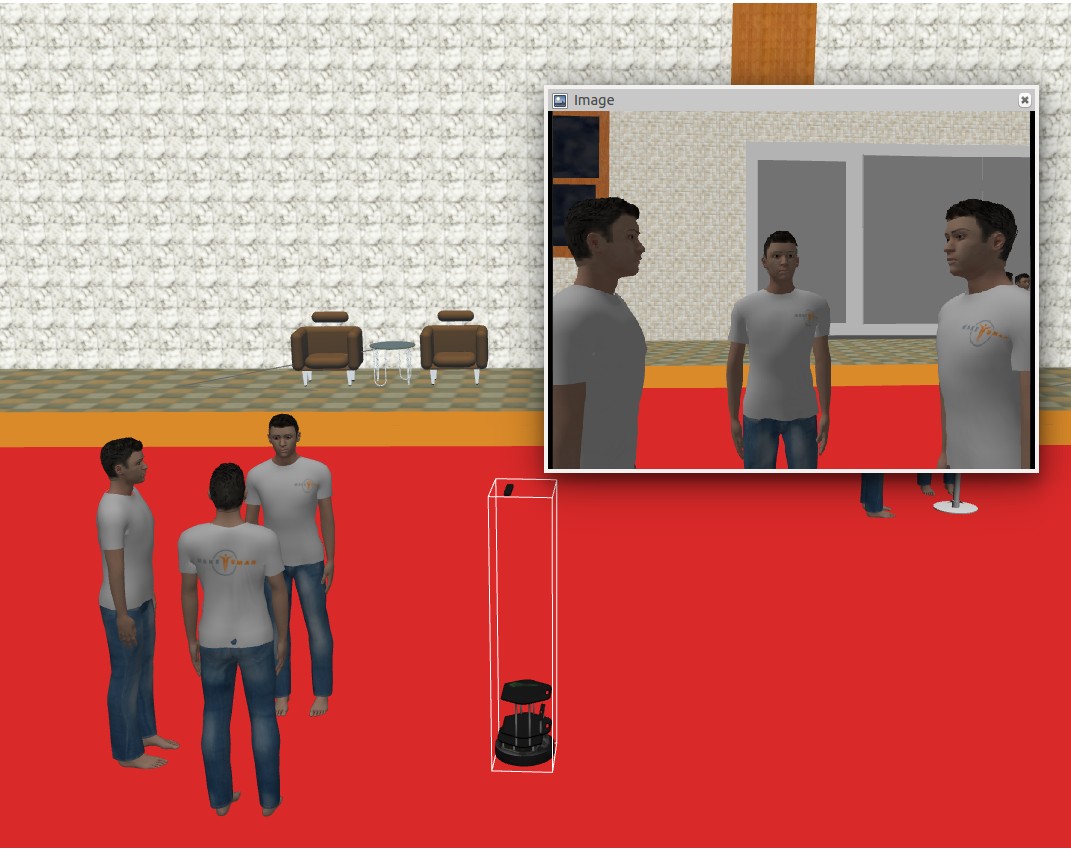
Figure 6. Image showing VAs interacting with each other and a modified TurtleBot observing. The inside image shows the view from the robot’s sensory system. This is the egocentric view seen by the subject while teleoperating a